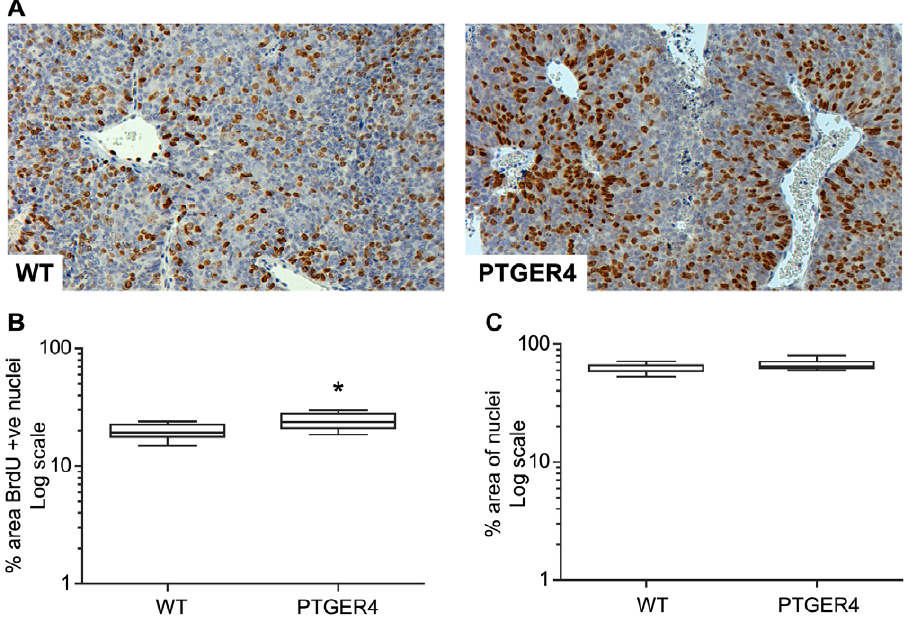
Figure 4. Cellular proliferation is enhanced in PTGER4 xenograft tumours. ( A ) Immunohistochemistry for detection of cellular proliferation in WT (n=7 sections) and PTGER4 (n=7 sections) xenograft tumours as determined by staining for BrdU incorporation in the nuclei. ( B ) Quantitative stereology of cellular proliferation in WT and PTGER4 xenograft tumours as determined by percentage area positively stained for BrdU incorporation in the cell nuclei. ( C ) Quantitative stereology of cell density in WT and PTGER4 xenograft tumours as determined by percentage area stained positive for nuclear counterstain. * represents significance at P , 0.05.